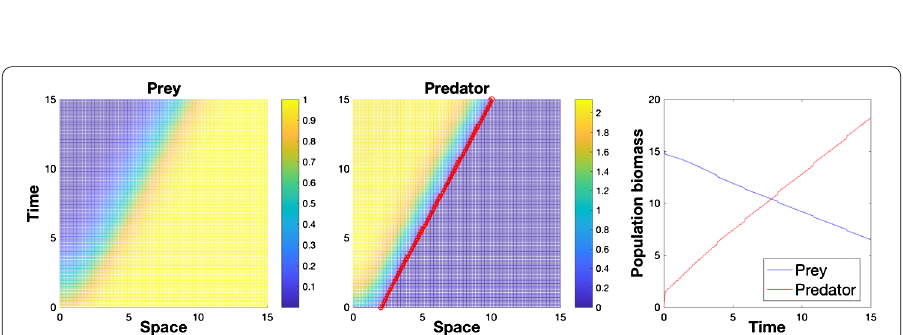
Figure 3 The smaller size of the initial invading domain. Graphical illustration of the invasion process of the generalist predator into the native prey species. The left two panels describe the spatio-temporal distribution of population density while the right-most panel shows population biomass. The bold red curve in the middle panel indicates the free boundary. Parameter values are a = 3, b = 3, c = 1, e = 1, h 0 = 1.2, μ = 0.8.